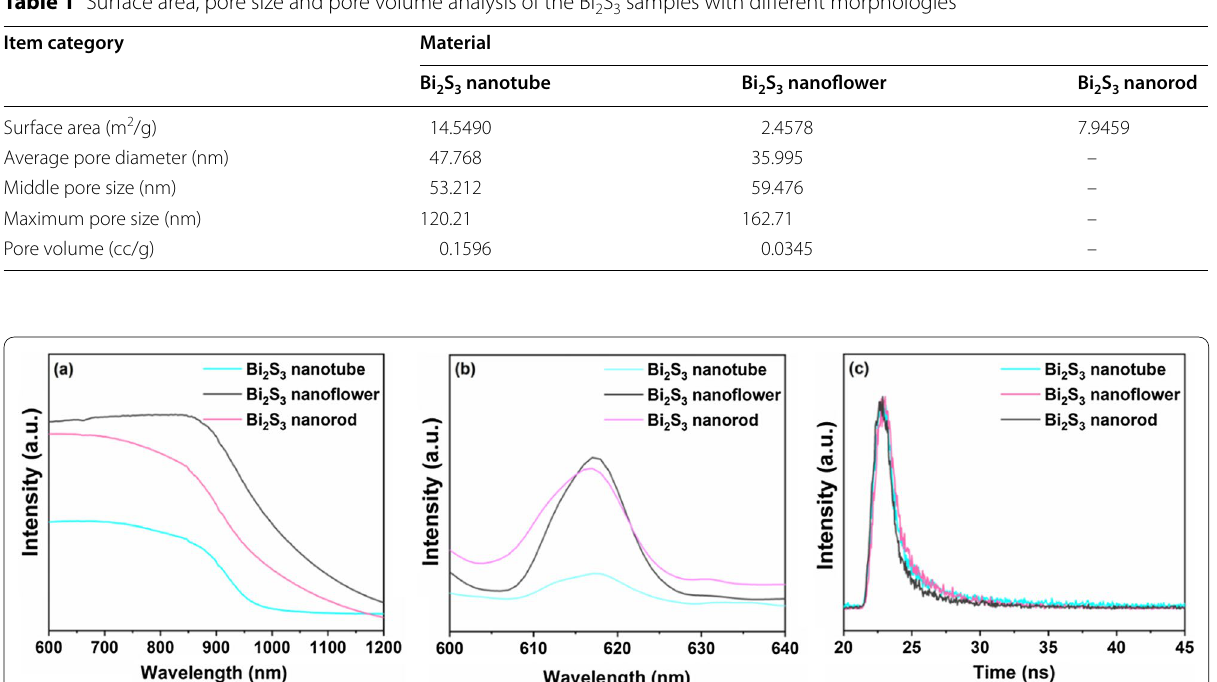
Table 1 Surface area, pore size and pore volume analysis of the Bi